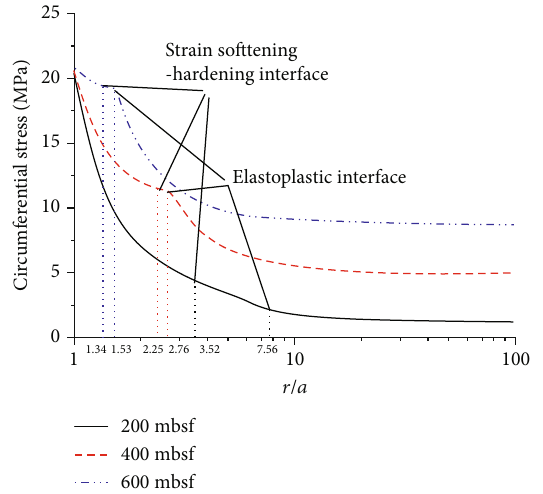
Figure 8: Relationship between circumferential stress and r / a at di ff erent depths.